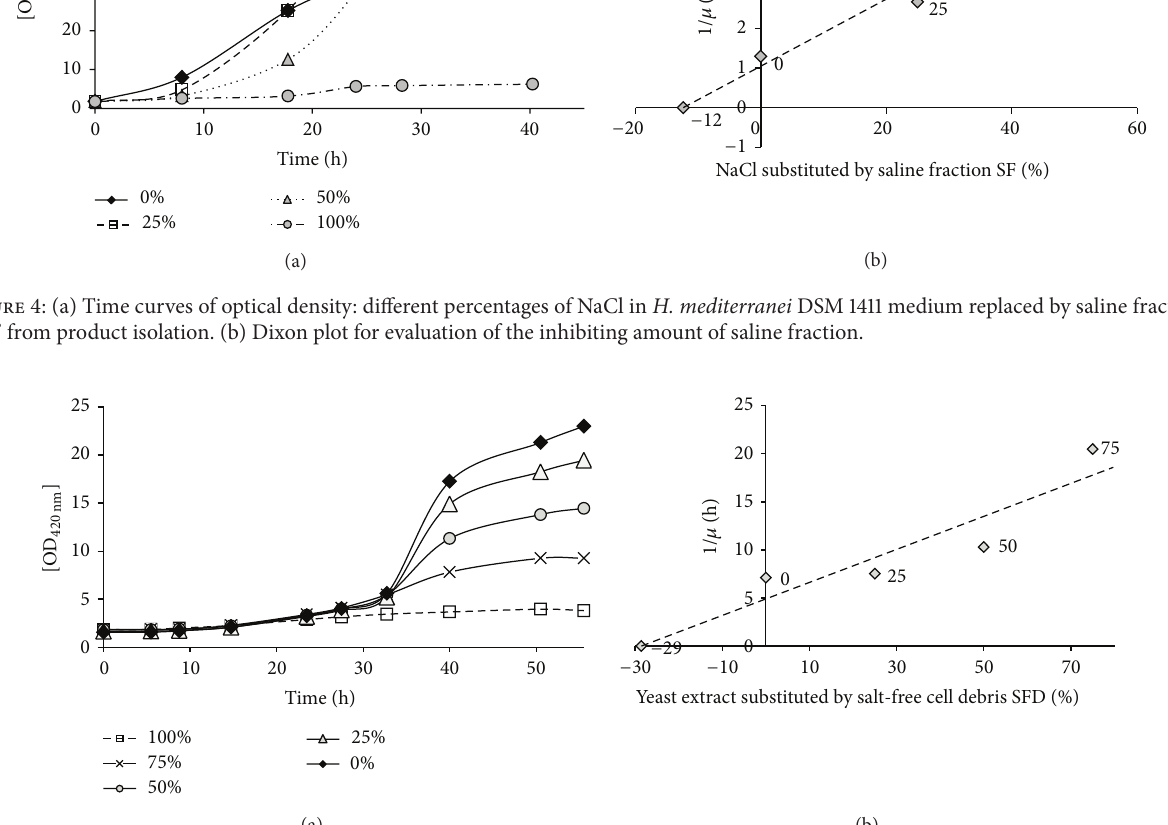
(a) and maximum specific growth rate 𝜇 max (b). The “classical” nm